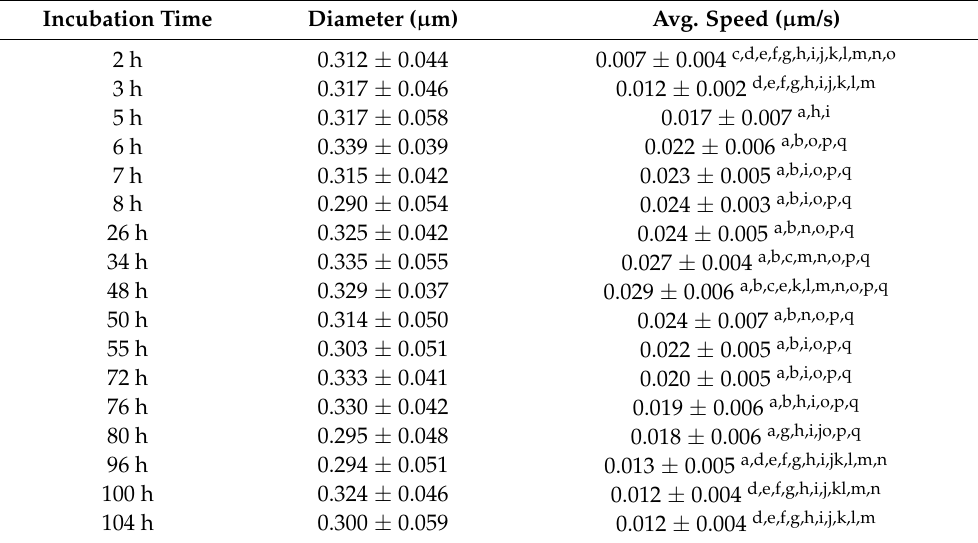
Table 2. Diameter and average speed of nanoliposomes over time from 2 to 104 h. Incubation